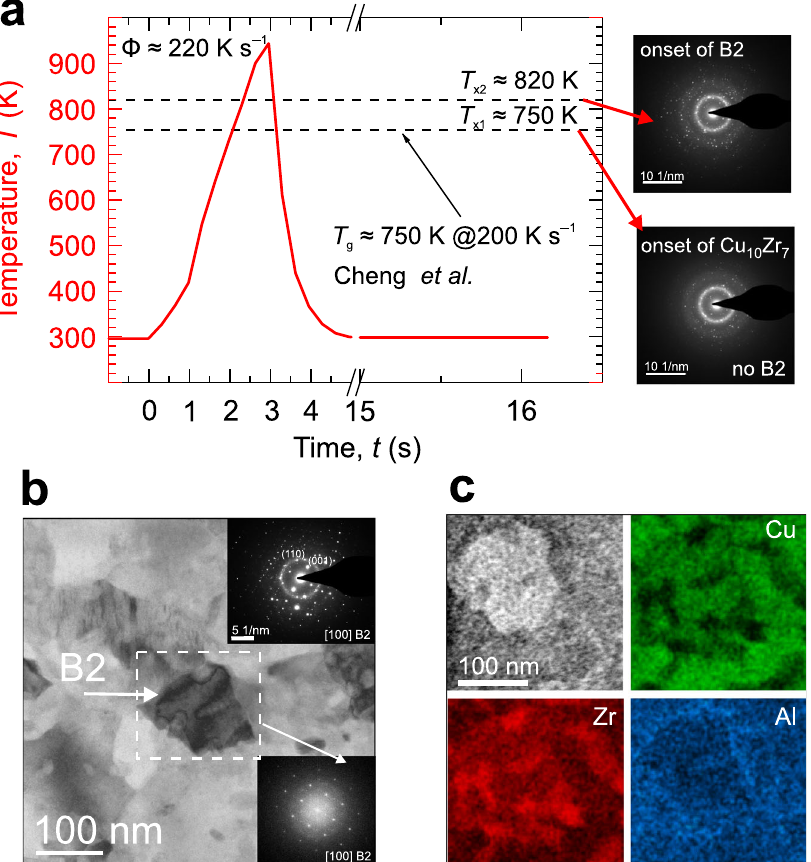
Fig. 5 In situ TEM showing the crystallization mechanism and the fi nal microstructure formed in a con fi ned environment at a subcritical heating rate of about 220 K s − 1 in a vacuum. a Heating pro fi le of a glassy Cu 47.5 Zr 47.5 Al 5.0 thin foil. Two crystallization temperatures T x1 and T x2 corresponding respectively to the onset of Cu 10 Zr 7 and B2 phase formation — represented on the right-hand by SAED patterns — can be identi fi ed. The value of the glass- transition temperature, T g , of a ribbon sample is taken from Cheng et al. 28 and was obtained by ultra-fast scanning calorimetry. The maximum temperature reached on heating was T max ≈ 944 K, followed by cooling at a rate of ~1090 K s − 1 . The phase transformation was con fi ned to a volume of ~16 × 0.05 μ m 3 (area × thickness). b Bright- fi eld STEM micrograph and SAED (inset in the top-right corner) of the fi nal microstructure. The white rectangle highlights a B2 grain surrounded mostly by Cu 10 Zr 7 , and it also marks the area of the corresponding fast-Fourier-transform pattern shown as the inset in the bottom-right corner. c HAADF image and the corresponding EDX of the individual elements (Cu: green; Zr: red; and Al: blue) of the area in the B2 crystal vicinity from part b